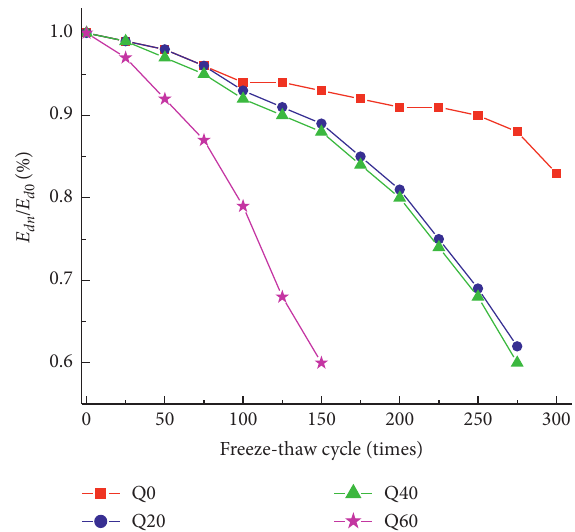
Figure 4: Relative dynamic elastic